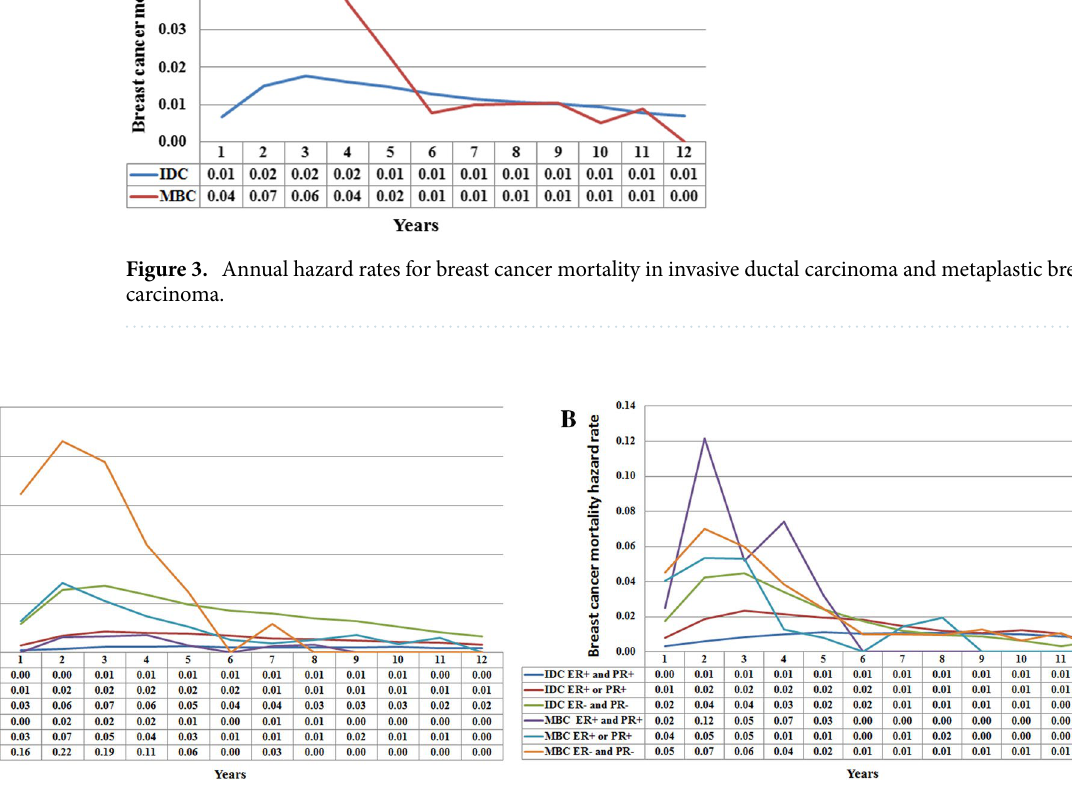
Figure 4. Annual hazard rates for breast cancer mortality in invasive ductal carcinoma and metaplastic breast carcinoma according to tumor stage ( A ) and hormone receptor status ( B ).